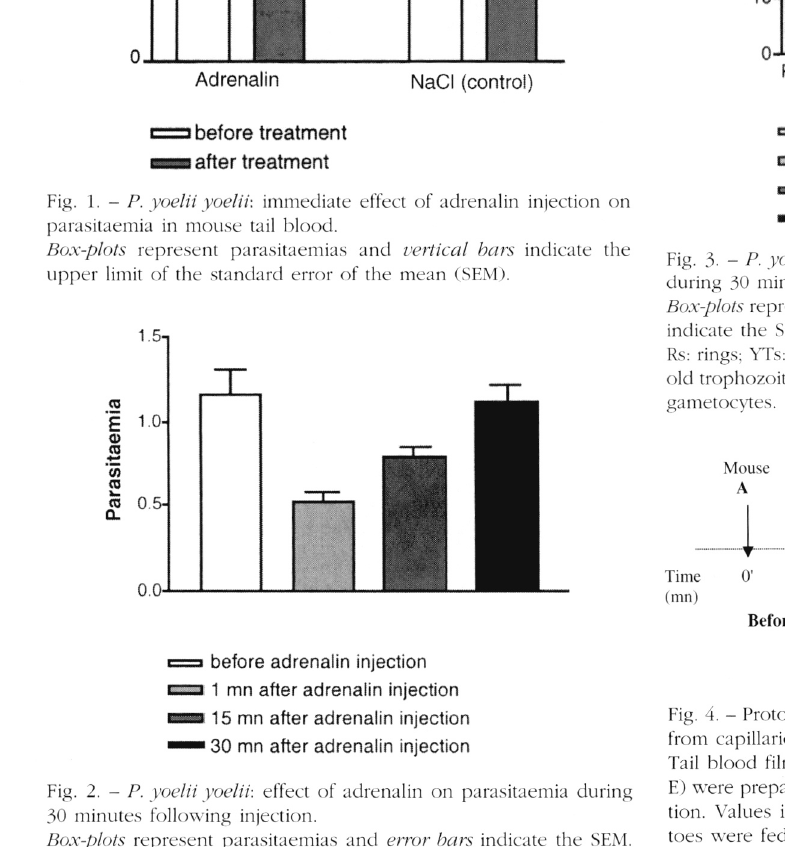
Fig. 4. - Protocol for comparing mouse tail blood with blood drawn from capillaries by mosquitoes. Tail blood films (A, C, D, F) and mosquito blood meal smears (B, E) were prepared before (A, B, C) and after (D, E, F) adrenalin injec­ tion. Values in mouse tail blood before (A) and after (C) mosqui­ toes were fed were